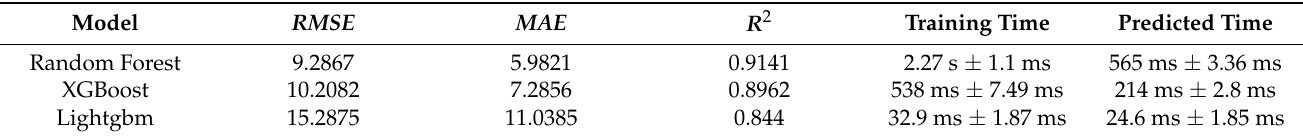
Table 5. Model performance